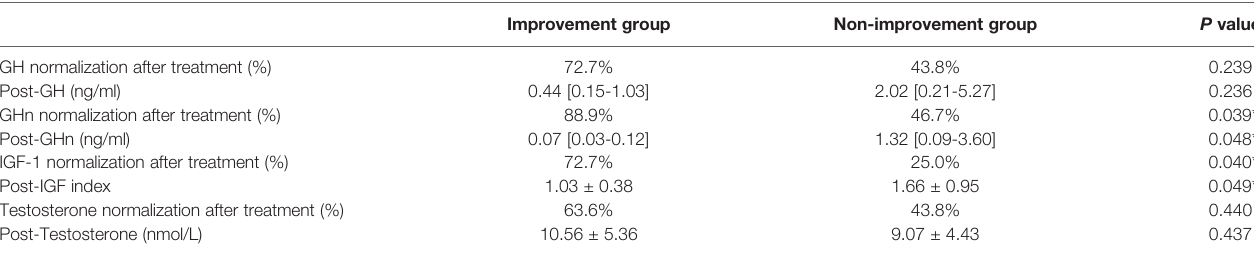
TABLE 5 | Univariate analysis between patients with and without improvement in erectile function after treatment.